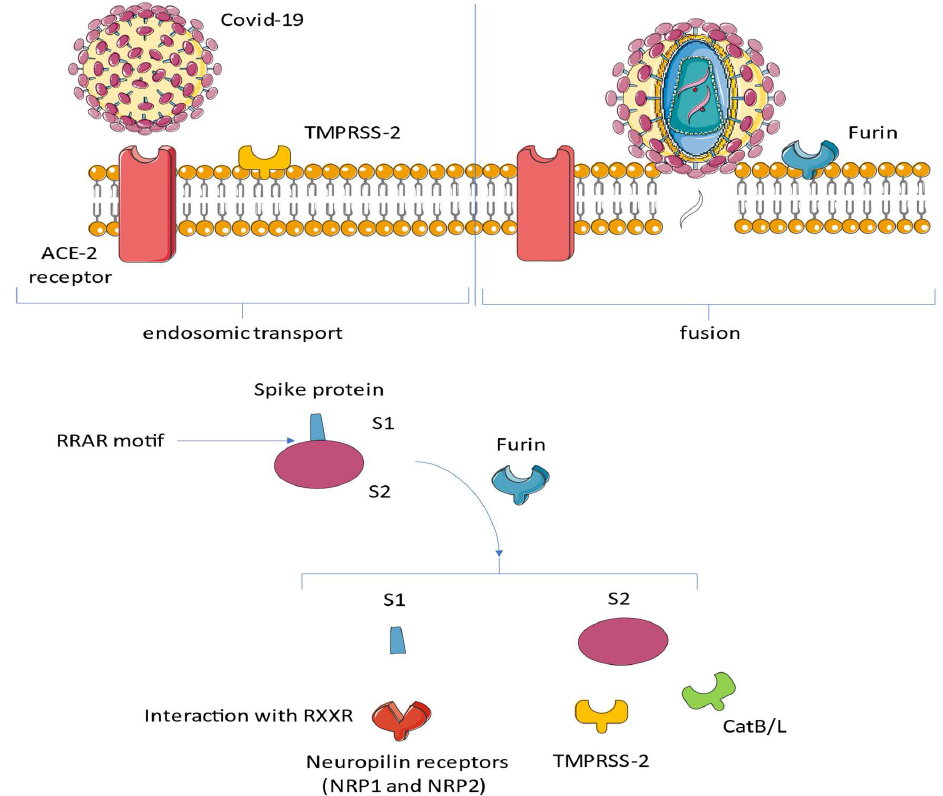
Figure 3. SARS Cov-2 has been shown to possess a marked tropism for cells expressing the ACE2 receptor on their surface. This tropism is mediated by the expression of specific proteases that act synergistically with ACE2. After binding of the spike glycoprotein (S) to the receptor, transmembrane serine protease 2 (TMPRSS2) and TMPRSS13 cleave the full-length spike protein (S0). This reaction promotes the conversion at its S2 site through a complex mechanism mediated by the selective function of the host’s furin. Neuropilin 1 (NRP1) binds the RRAR motif’s carboxyterminal sequence of the spike exposed after furin cleavage. Abbreviations: ACE, angiotensin-converting enzyme; CatB/L, cathepsin B/L; NRP1, neuropilin; S, spike; RAR, RaTG13 virus lacks the furin cleavage motif RRAR ↓ S; and TMPRS, transmembrane protease, serine.